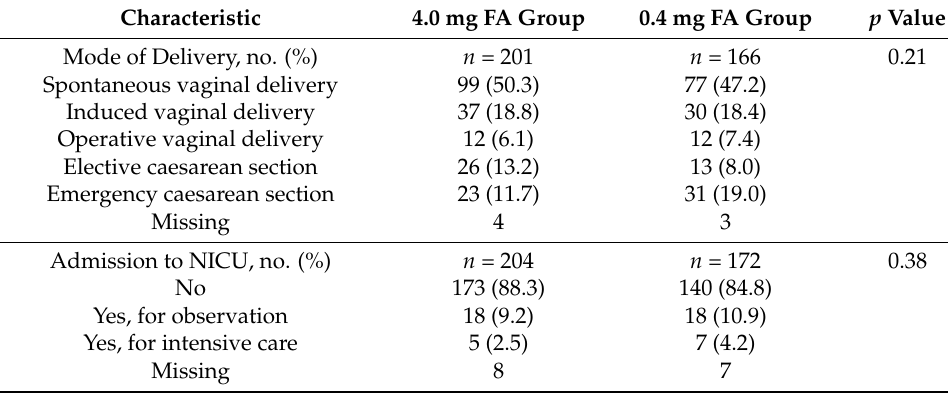
Table 4. Mode of delivery and admission to